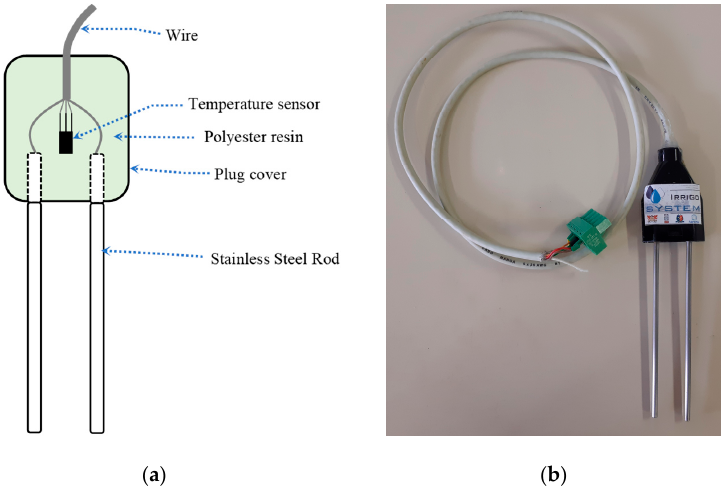
Figure 3. ( a ) Scheme of the probe for measuring σ and ε ; ( b ) Probe used in the experiments.